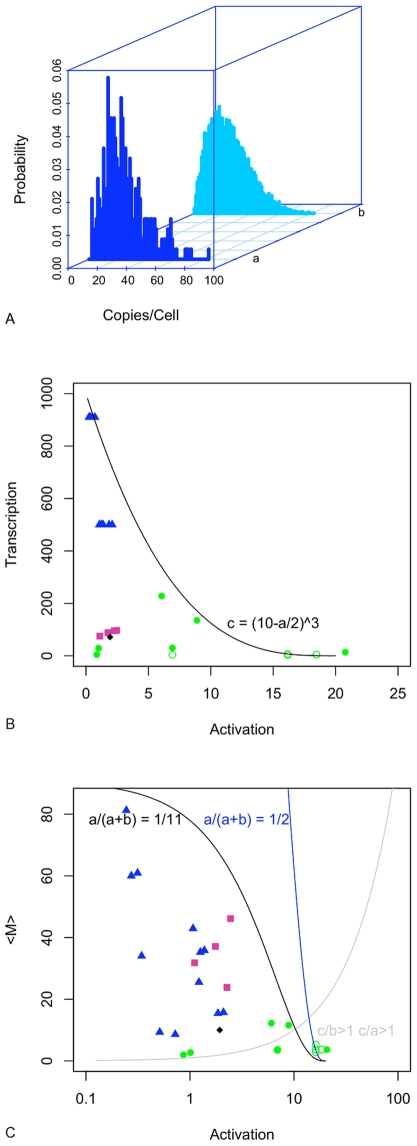
Modelling mRNA expression in single cells.A. Distribution of mRNA, a. observation and b. model. B. Scatterplot of  and  parameters from published models: blue triangles indicate mammalian data [4], green circles indicate yeast [7], as do purple squares (this paper), and the black diamond shows data from E. coli
[2]. Closed symbols are plotted when , open symbols indicate . All parameters have been scaled such that  as in preceding figures. The line is an empirically-derived equation for the upper limit of . C. Scatterplot of  values and  parameters from published models, symbols are defined as in B. Blue and black lines are the predicted upper constraint on  for alternative assumptions about the proportion of time in the on state. The grey line is .